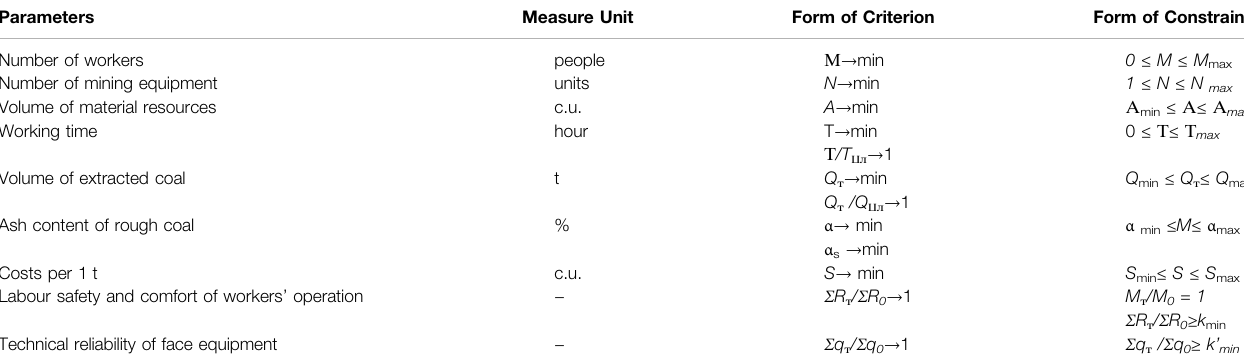
TABLE 3 | Characteristics of the ef fi ciency of a coal mining process.